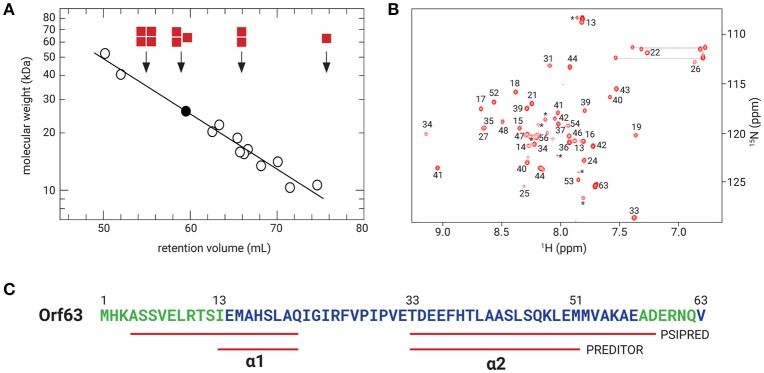
Orf63 structural insights. (A) The retention volumes for a set of proteins ranging from 10–67 kDa were plotted against molecular weight to produce the log-linear relationship shown (open circles). The Kav value observed for Orf63 corresponds to an apparent molecular weight of ~28 kDa (closed circle). For reference, red squares denote the expected retention volumes of monomeric, dimeric, trimeric, and tetrameric species of the 9 kDa affinity tagged Orf63 protein. (B) A representative 1H-15N HSQC spectrum of Orf63 at 37°C demonstrating the characteristic resonance dispersion of a folded protein. Unassigned residues are labeled with an asterisk. Lines denote the amino resonances of three asparagine and glutamine side chains. (C) A conventional strategy was used to assign the backbone (HN, N, CA, CB, C') chemical shifts of Orf63. The extent of these assignments is colored blue on the sequence. The chemical shift data were then used as input to PREDITOR (Berjanskii et al., 2006) which identified two helices labeled α1 and α2. Using sequence data alone as input to PSIPRED (McGuffin et al., 2000), longer helices are predicted.